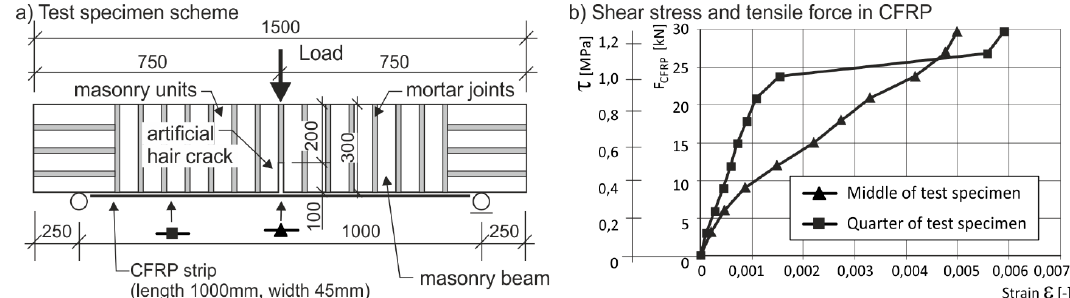
Figure 11. Experimental verification of the carbon strip–masonry bond: ( a ) test scheme and ( b ) shear stress to strain relationship.